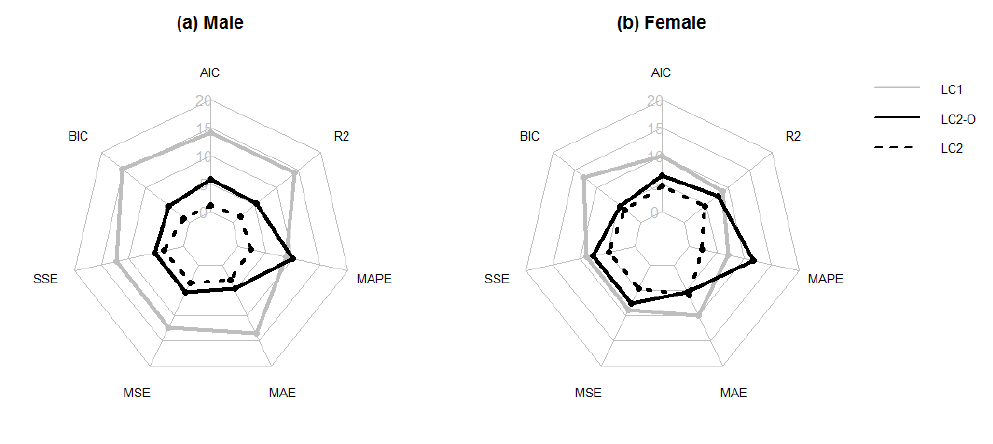
Figure 3. Radar graph summarizing the number of countries for which each model (LC, LC2, and LC2-O) achieves the best forecasting ability according to the hold-out method for males ( a ) and females ( b